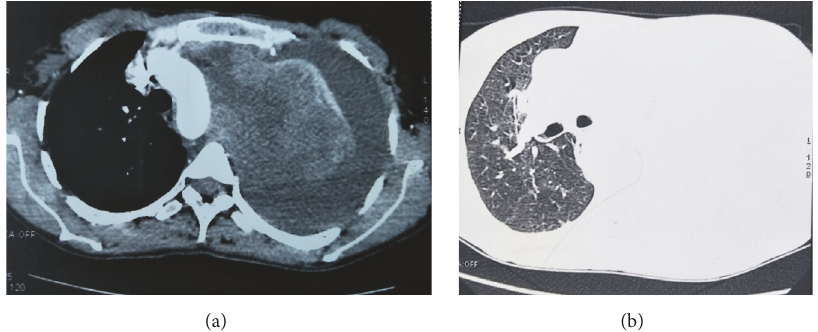
Figure 2: CT scan image showing a left mediastinal-pulmonary tumor process [(a) mediastinal window. (b) Parenchymal window].